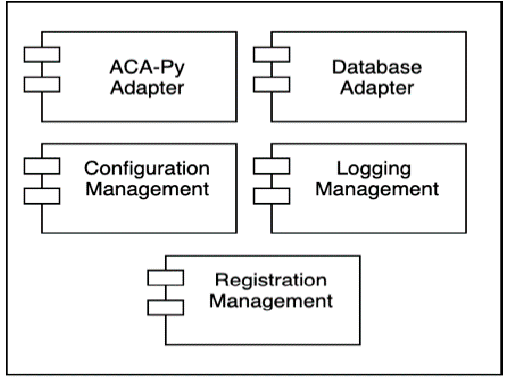
Figure 13. EMSP software modules.